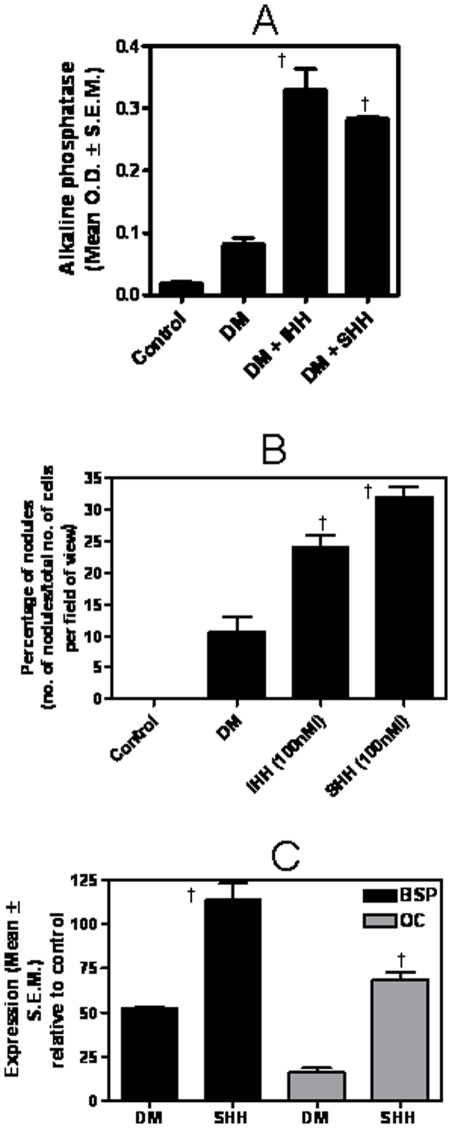
Activation of Hh signaling promotes differentiation and mineralization activity of osteoblasts.MC3T3 E1 Sc-14 cells were grown in differentiation medium (DM) supplemented with either with 100 nM recombinant SHH or IHH or without. Cells grown in normal growth medium were used as control. (A) Differentiation was assessed by alkaline phosphatase (ALP) assay. Under differentiation conditions that included recombinant IHH or SHH, the ALP activity was significantly greater († indicates p<0.0001) relative to DM alone. (B) Relative to control (growth medium), DM induced the formation of mineralized nodules. Relative to DM the media spiked with recombinant IHH and SHH supports the formation of significantly greater number of mineralized nodules († indicates p = 0.012 and 0.002, respectively). The number of nodules formed due to each treatment is represented as a percentage of the total number of cells present in each field of view. Control represents growth medium. The number of mineralized nodules in 12 independent fields per well were scored. (C) The expression of osteoblast differentiation marker genes, BSP († indicates p = 0.0027) and osteocalcin († indicates p = 0.0004) is significantly elevated in presence of SHH at the end of 14 days. Cells were harvested and RNA extracted which was used in real time quantitative RT-PCR assay. The fold change in expression is represented relative to control (growth medium).